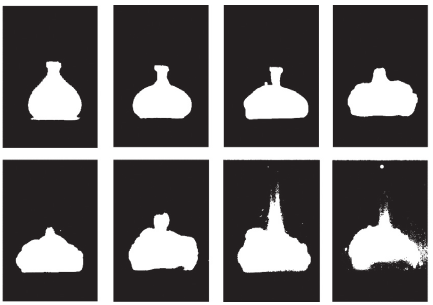
Figure 13: Binary image of the droplet radius (wire feed speed is 5.0